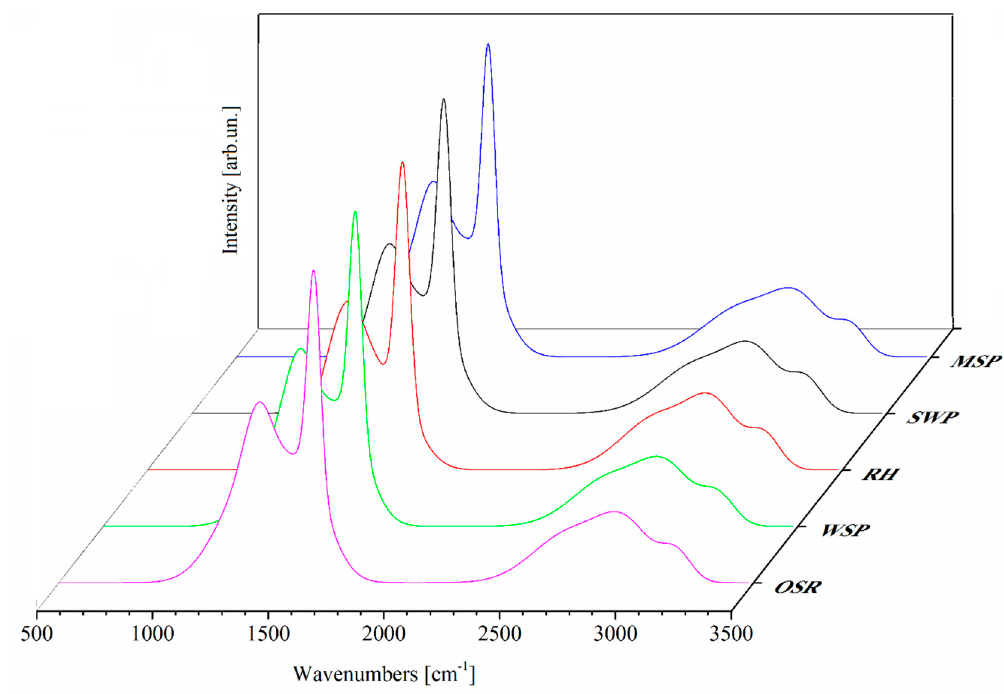
Figure 4. Raman spectra of biochars in the range between 500 cm − 1 to 3500 cm − 1 .